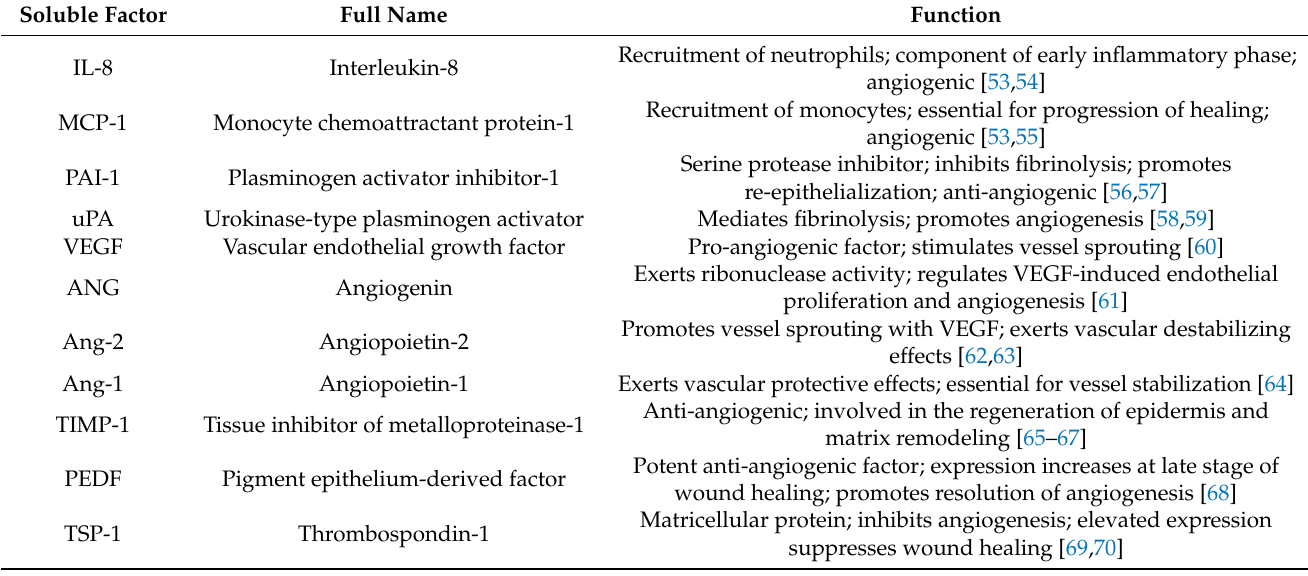
Table 1. ADSCs’ secreted factors and their role in angiogenic wound